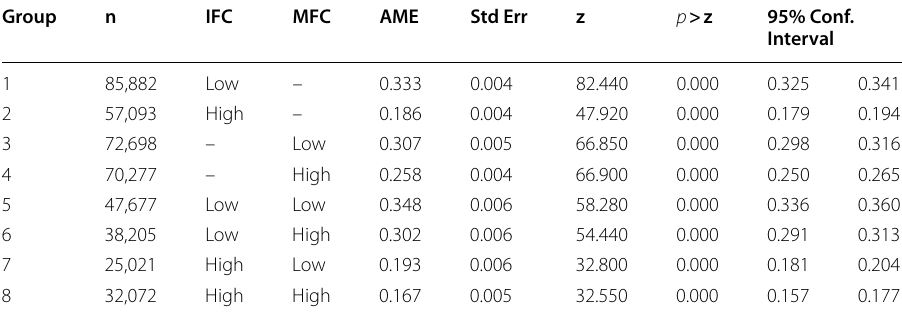
Table 4 Average marginal effects of innovation output on financial performance under different levels of financial